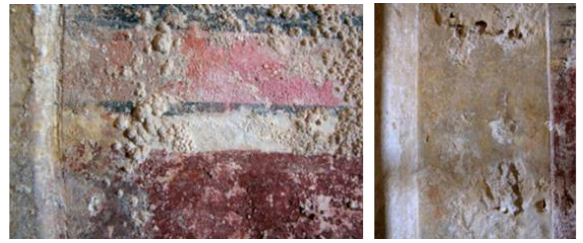
Figure 3. Efflorescence on the surface of the wall paintings at